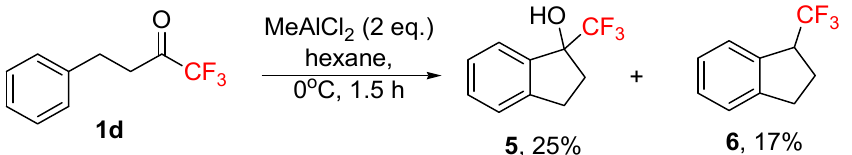
Scheme 4. MeAlCl 2 -promoted synthesis of 1-CF 3 -indan-1-ol 5 and 1-CF 3 -indan 6 from CF 3 -ketone 1d .